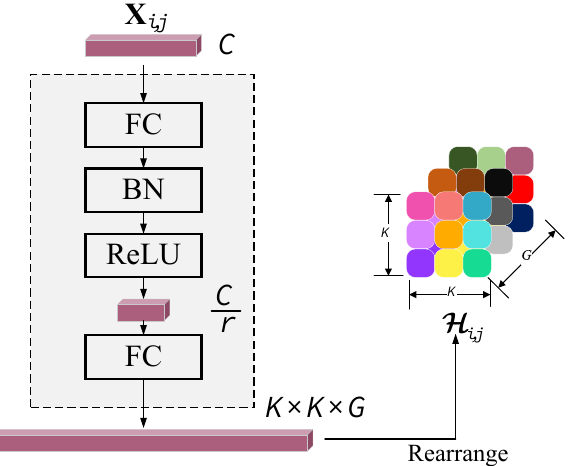
Figure 5. The schema of the spectral feature-based dynamic kernel generation function. X i , j denotes the spectral feature at position ( i , j ). H i , j refers to the corresponding involution kernel. After the generation of the involution kernels, the output feature maps can be derived by performing multiply-add operations on the local blocks of the input with their corre- sponding kernels, as shown in Figure 6. The sliding local blocks can be easily extracted by using the unfold technique in Pytorch [63]. Note that the unfold operation materializes intermediate tensors with the shape of ( H × W ) × K × K × C , which causes involution to consume more memory resources than standard convolution.